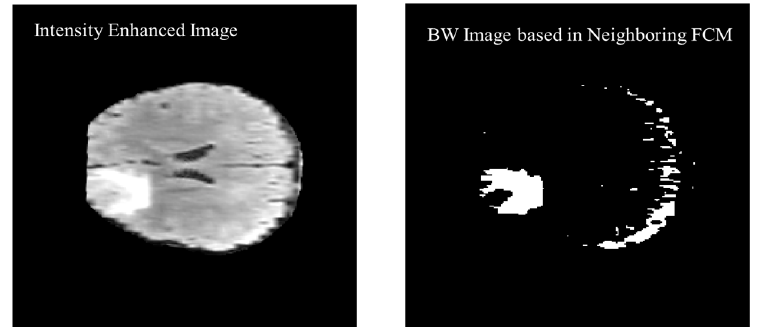
Figure 11. Black and White (BW) binary image generated based on the neighboring FCM threshold applied to intensity enhanced image.